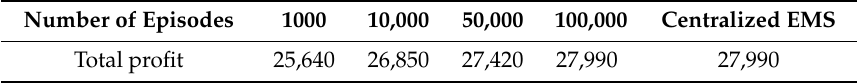
Table 3. Total profit of CBESS with the di ff erent number of episodes and centralized EMS.